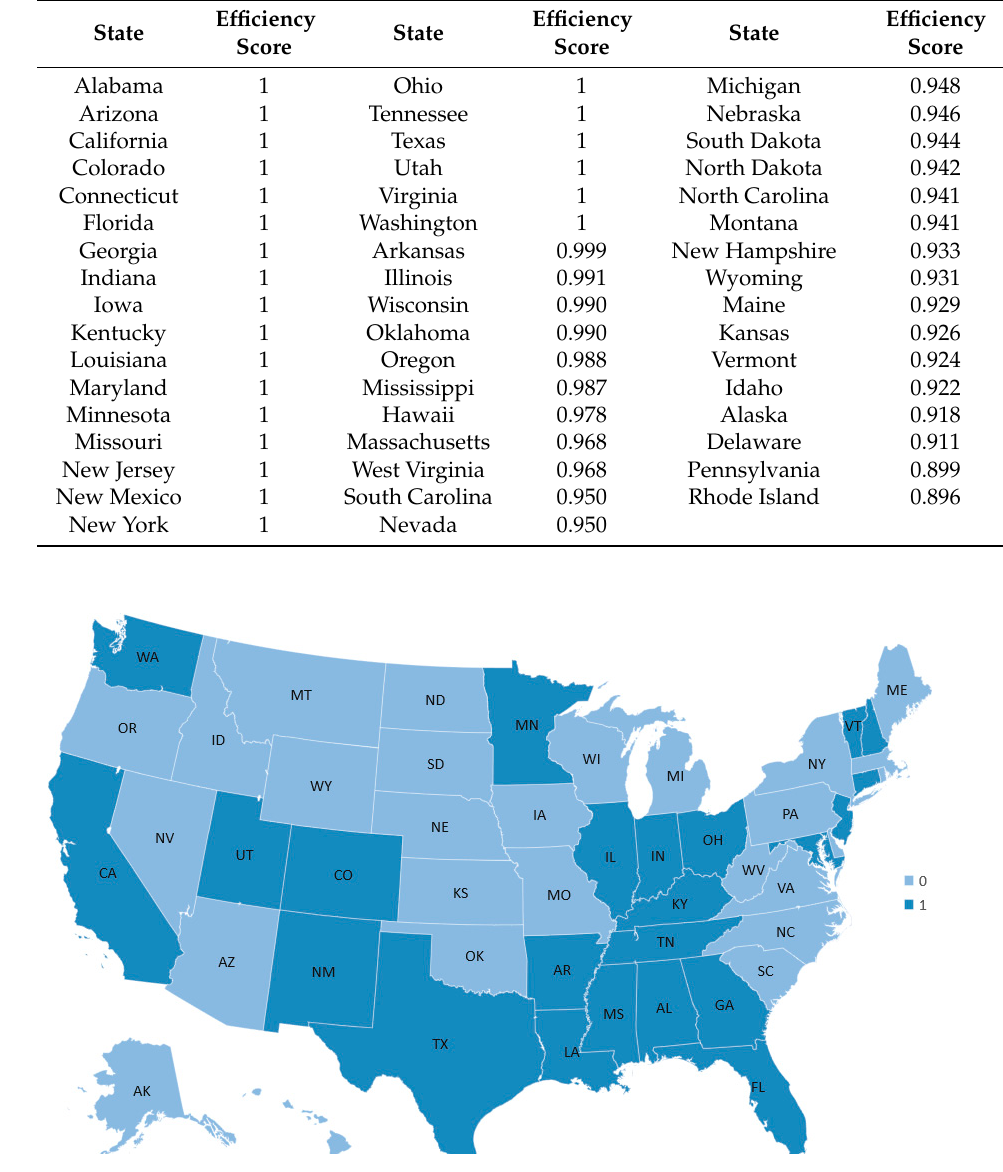
Figure 2. Efficient and Inefficient State (1 is Efficient state, 0 is Inefficient